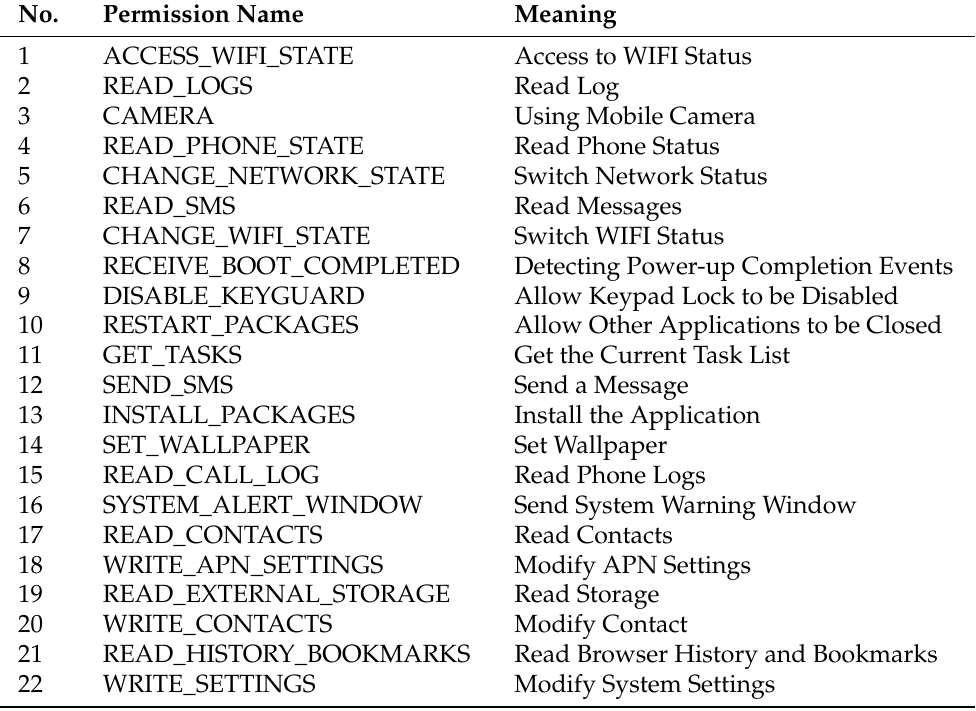
Table 3. The 22 selected permissions and their corresponding